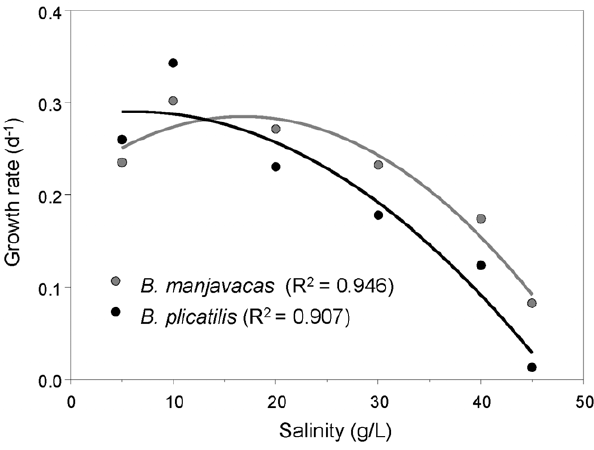
Figure 4. Relationship between mean r values and salinity. Relation between mean r values, after averaging over clones and replicates, of B. plicatilis and B. manjavacas , and salinity. Curves are least-squares quadratic functions. Determination coefficients (R 2 ) are shown.